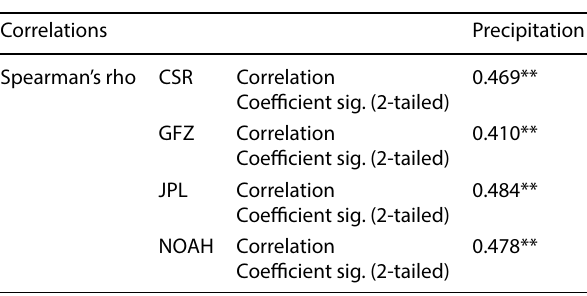
Fig. 5 Seasonal TWS variations estimated by GRACE for the period of 2003–2016. Mann–Kendall’s trend test τ and Sen’s slope estimator “S” Table 2 Correlation between precipitation with CSR, GFZ, JPL and GLDAS-Noah computed using Spearman’s rho method